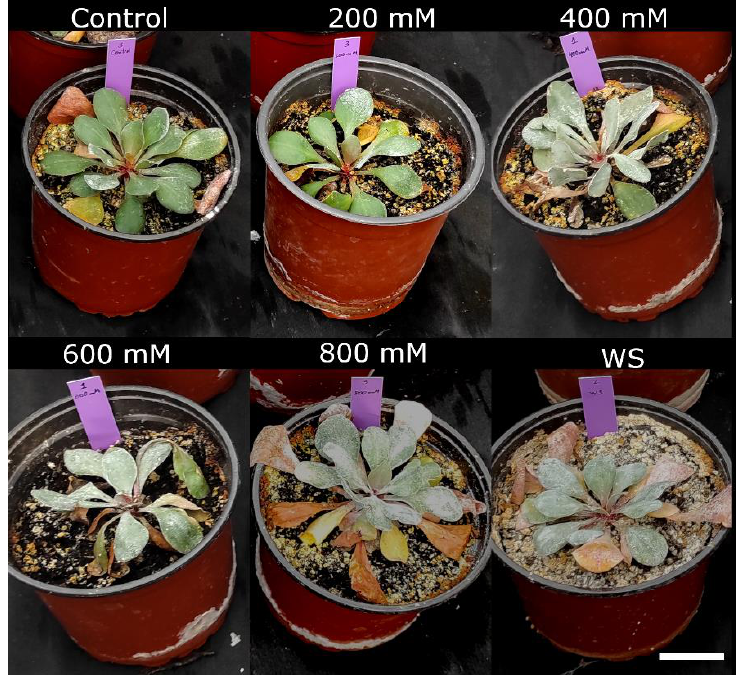
Figure 1. Effect of four weeks of salt treatments with the indicated NaCl concentrations, or water stress (WS), on Limonium angustebracteatum plants. The scale bar represents 3 cm. The number of leaves at the end of the treatments was compared to that at the begin- ning of the experiments. Except for the control plants, irrigated with non-saline water, where some new leaves were produced (1.8 per plant, on average), the number of leaves decreased in all other treatments, especially in the presence of 800 mM NaCl and under water stress conditions (Figure 2a). The mean leaf area also decreased compared to the control, significantly in plants of the 600 and 800 NaCl and the water stress treatments (Figure 2b). Root fresh weight decreased in all cases with respect to the control, notably in water-stressed plants, where an eight-fold reduction was recorded (4.34 vs. 37.87 g); although significant, the salt-induced reduction in root fresh weight was much less pro- nounced, down to about 50% of the control, without significant differences between the salt treatments (Figure 2c). Average values of leaf fresh weight were also lower in the stressed plants than in the non-stressed control, but the differences were significant only in the presence of 400 mM NaCl or after the water stress treatment (Figure 2d); in any case, this reduction (30 − 40% of the control) was not as substantial as for the root fresh weight. Another relevant parameter is the water content of the plants, calculated by the ratio between fresh and dry weight. As expected, water content decreased significantly in the water-stressed plants, especially in the roots (17.1% compared to 75.0% in